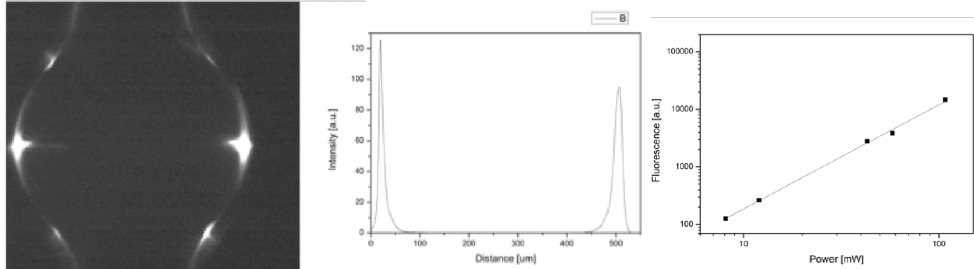
Figure 14. Fluorescence image of the MBR filled with 10 − 6 solution of Rhodamine 6G, showing the TPF lobes, the corresponding intensity plot (center) and the TPF signal versus the pump laser power in log-log scale. The red line is the linear fit with slope close to 2. The probe wavelength is λ pump = 800 nm. Reproduced with modifications from